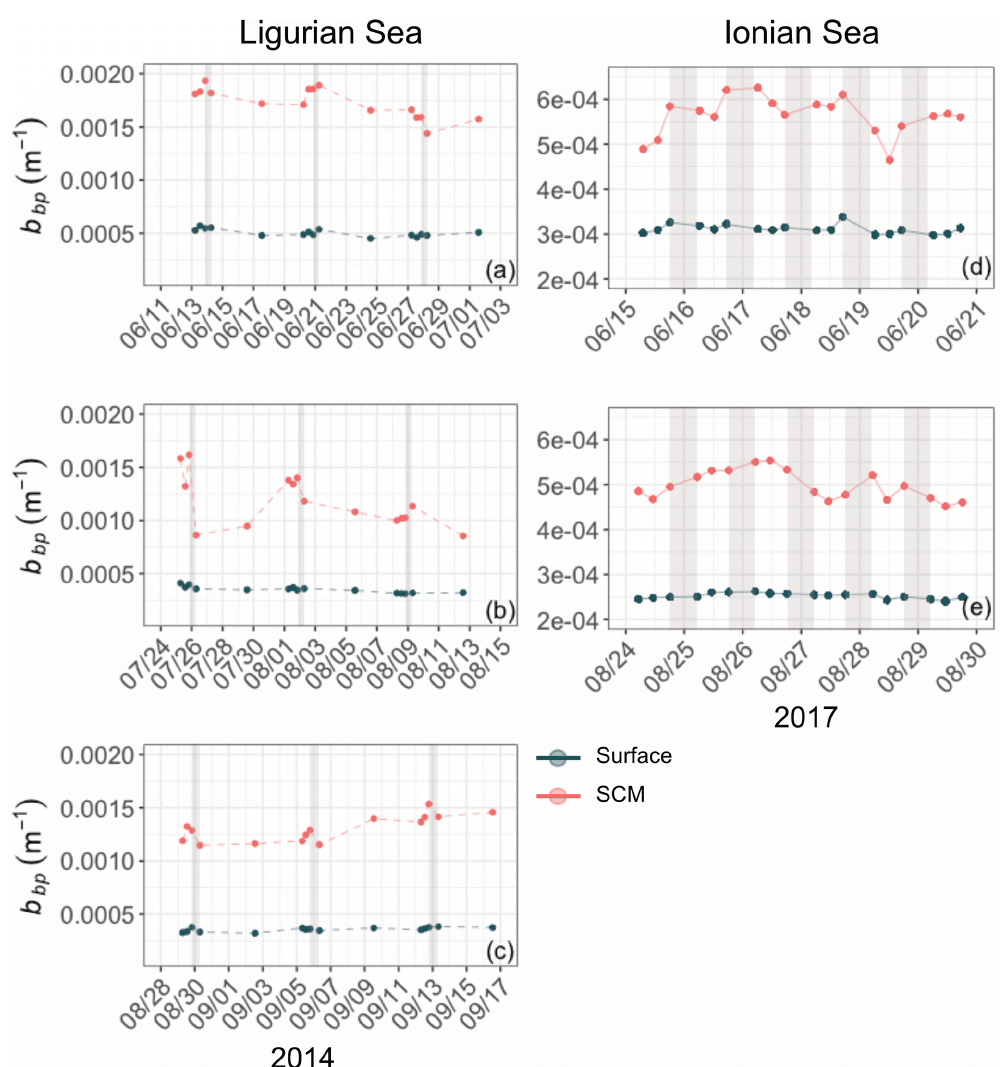
Figure A2. Example of time series of the b bp coefficient in the surface (red) and SCM (dark green) layers, chosen within the time periods indicated by the dashed lines in Figs. 3–4, from 24 May to 14 July 2014 (a) , 14 July to 16 August 2014 (b) and 16 August to 13 Septem- ber 2014 for the Ligurian Sea (a–c) and from 28 May to 11 August 2017 (d) and 11 August to 11 September 2017 (f) for the Ionian Sea (d–e) . Please note that the date format in this figure is